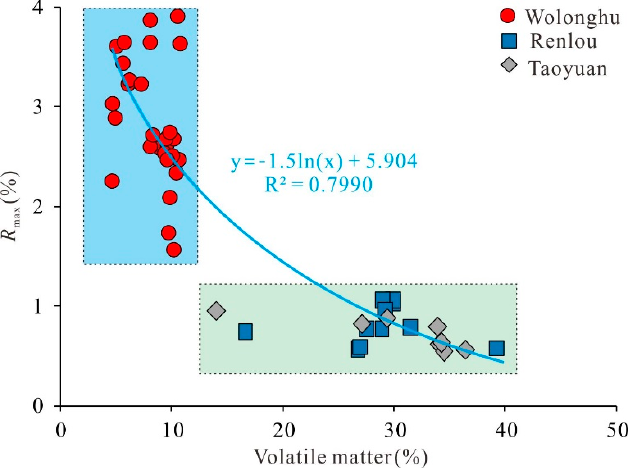
Figure 10. Correlation between volatile matter and R max of the selected samples in the Huaibei Coalfield.